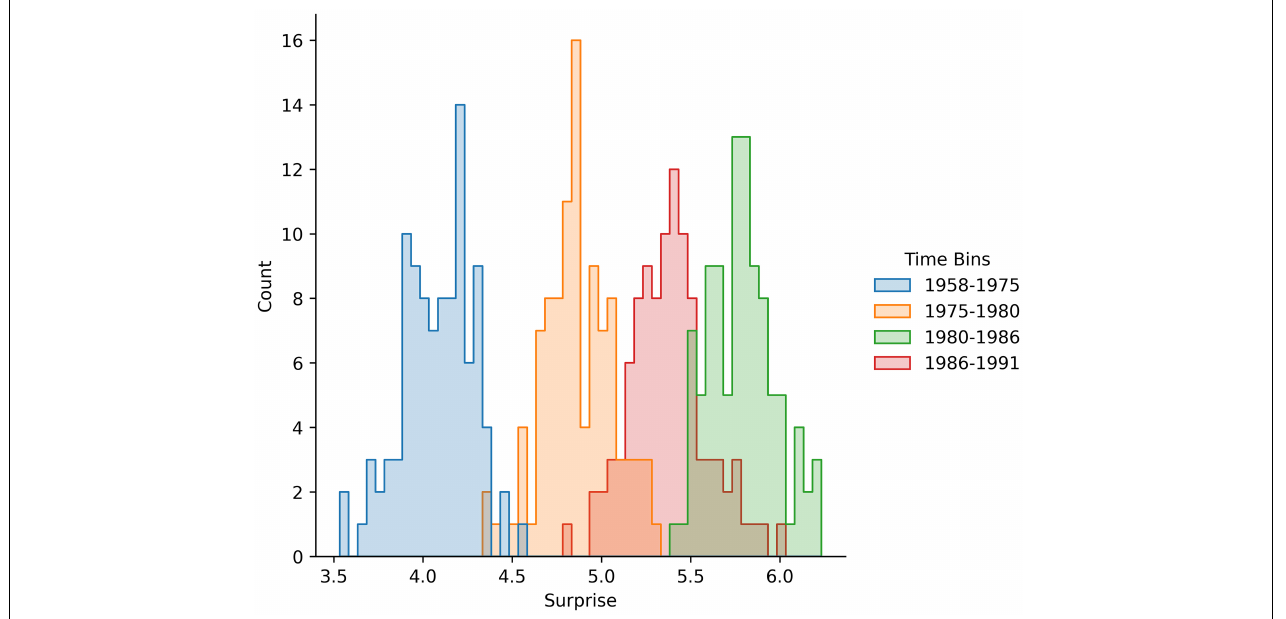
FIGURE 5 | Amount of surprise uses temporally integrated expectations. These schematic histograms are simulated from the data in Figure 1 of Miles et al. (2021a). The simulations assume Gaussian distributions of absolute amount of surprise, with the mean and standard deviation as in Miles et al. (2021a) results. The simulations also assumed a sample of 100 songs per distribution. The average amount of surprise (in bits) is relative to the chord distribution of August 1958 to January 1975. The analyses performed by Miles et al. (2021a) showed increased amount of harmonic surprise over time, specially for songs in the top of the Billboard Top